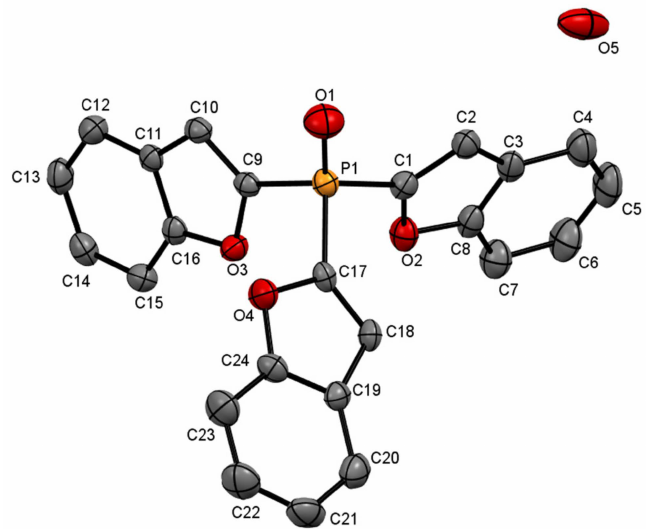
Figure 1. Compound 13 in the asymmetric part of the unit cell. The displacement ellipsoids are drawn at the 50% probability level. Hydrogen atoms are omitted for clarity.